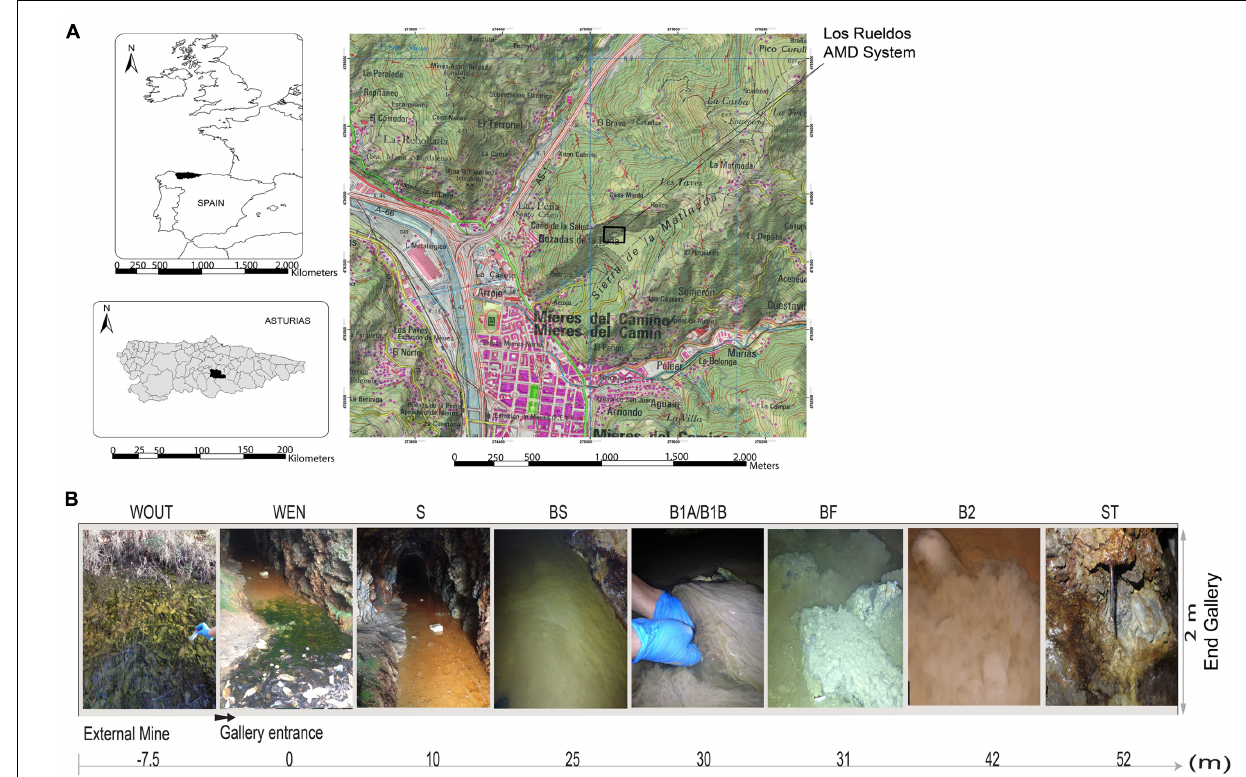
FIGURE 1 | Maps of the Los Rueldos emplacement in Asturias (NW Spain) (A) . Depiction of the sampling locations along the AMD (B) .